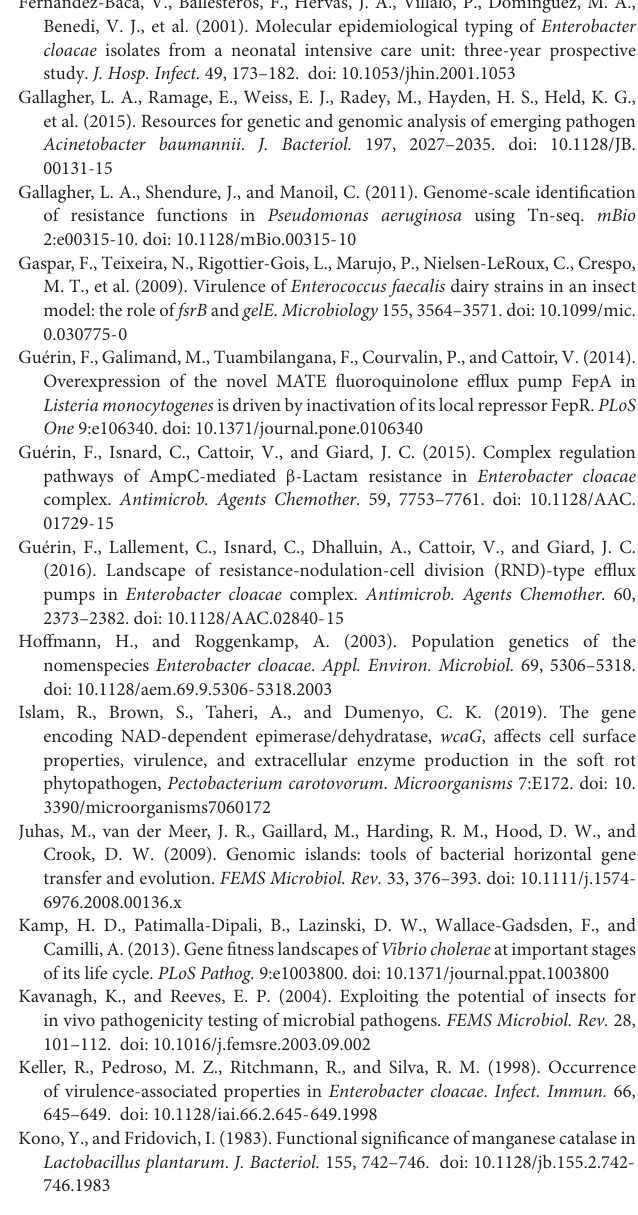
FIGURE S1 | Genetic organization of the selected genes and surrounding regions whose deletion mutants have been created. FIGURE S2 | Growth curves of E. cloacae ATCC 13047 and mutant strains at 37 ◦ C in LB. FIGURE S3 | (A) Percentage of survival after 2 hours at pH 5 at 37 ◦ C in LB. No statistical difference was observed compared to the wild type. (B) Percentage of autolysis after 10 hours of incubation at 37 ◦ C with 0.5% of Triton 100X. No statistical difference was observed compared to the wild type except for the (cid:49) acrB mutant used as positive control. TABLE S1 | Primers used in this study. TABLE S2 | MICs ( µ g/ml) of antibiotics, antiseptics and biocides for E. cloacae ATCC 13047 and mutant strains of E. cloacae .